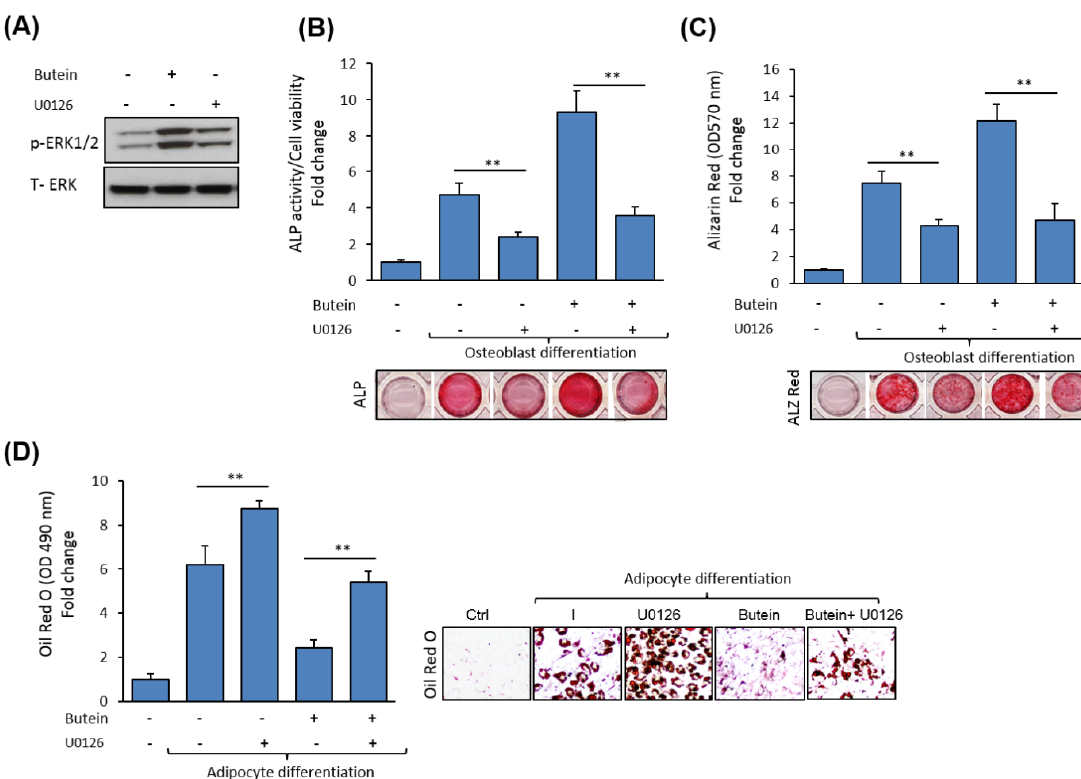
Figure 5. Butein exerts its effect on mBMSCs differentiation via an ERK1/2-dependent pathway. ( A ) Inhibitory effect of the specific ERK1/2 (activating extracellular signal-regulated kinase), U0126 on butein-induced ERK1/2 phosphorylation, as assessed by Western blot analysis. ( B ) The stimulatory effect of butein on osteogenesis in mBMSCs is abolished by blocking ERK1/2 activation, as measured by ALP activity and ( C ) Alizarin Red staining quantification. Cells induced to differentiate into osteoblast were pre-treated with U0126 (10 µM) in the absence or the presence of butein (30 µM) for 6 days (for ALP activity staining) or 12 days (for Alizarin Red staining). ( D ) The inhibitory effect of butein on adipogenesis in mBMSCs is rescued by U0126 pretreatment. Quantification of Oil Red O staining was performed after 12 days. Values are mean ± SD of three independent experiments, (** p < 0.005).